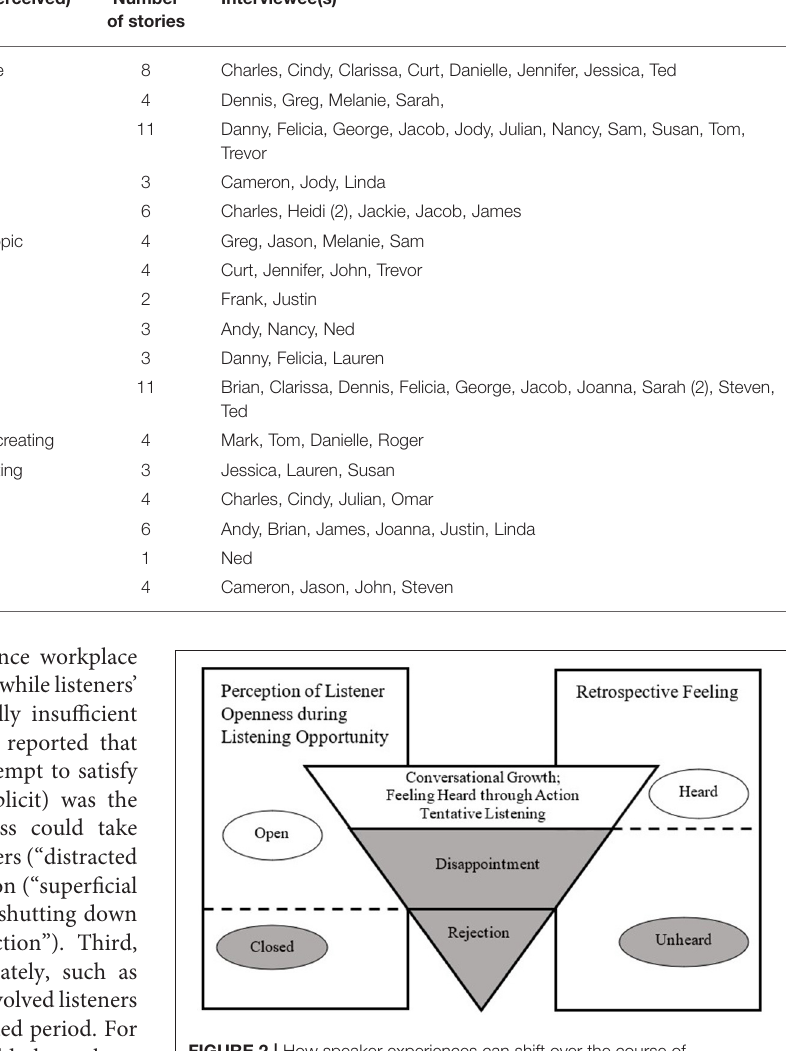
TABLE 3 | Listening path, classification, and behaviors. Path